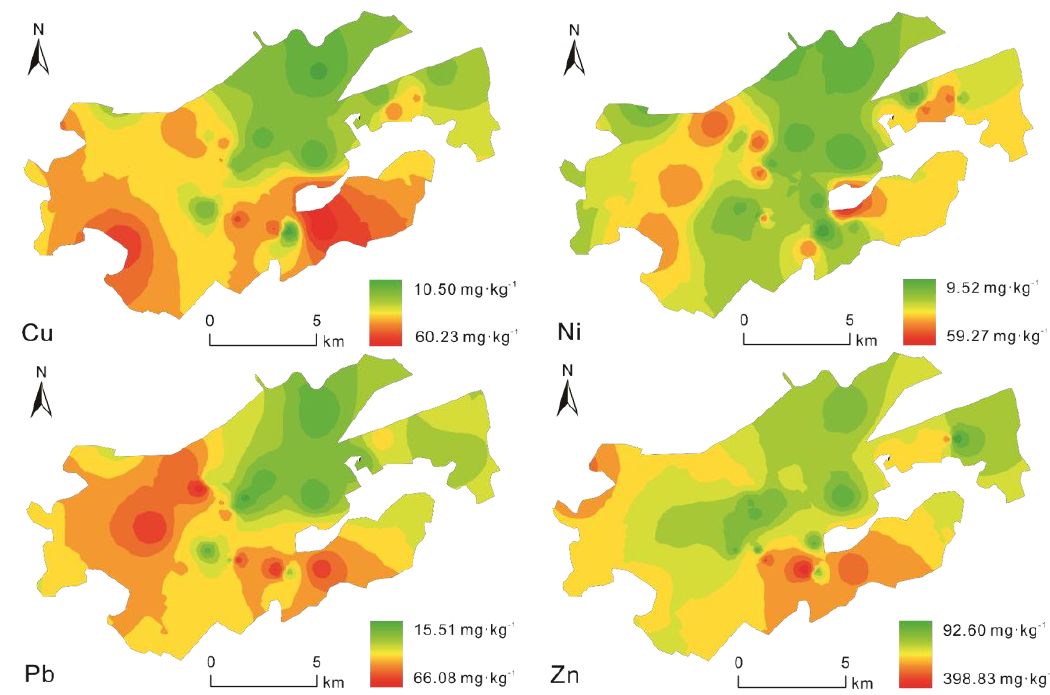
Figure 4. Spatial distribution of soil heavy metals in the study area.